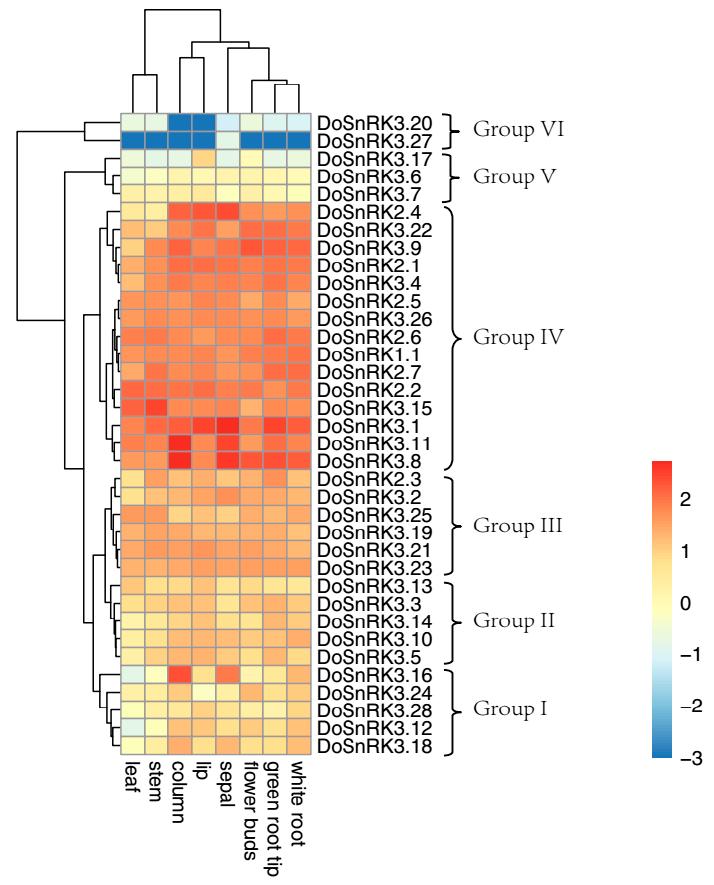
Figure 5. Expression patterns of 36 DoSnRK genes in eight tissues of D. officinale . The expression levels were based on the RNA sequencing data [43]. The eight tissues tested included the column, flower bud, lip, sepal, leaf, stem, white root, and green root tip. The color scale stands for the values of log 2 (FPKM + 0.001).